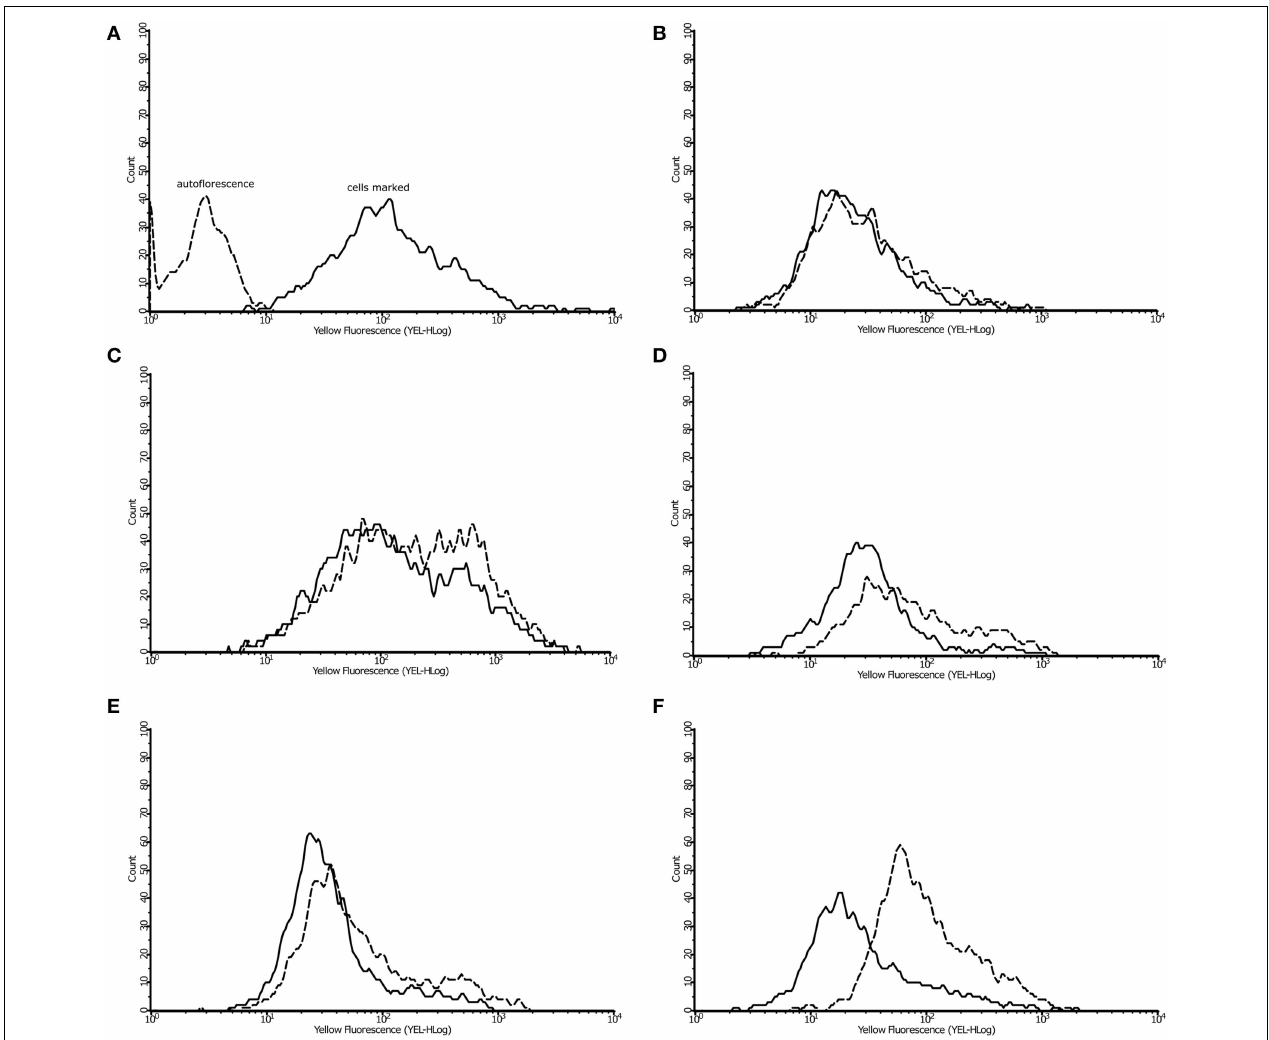
absence of argentilactone for (B) 0h, (C) 6h, (D) 10h, (E) 12h, and (F) 24h wasperformed.Linehistogramsrepresentthecellstreatedwithargentilactone and dotted histograms represent control cells without